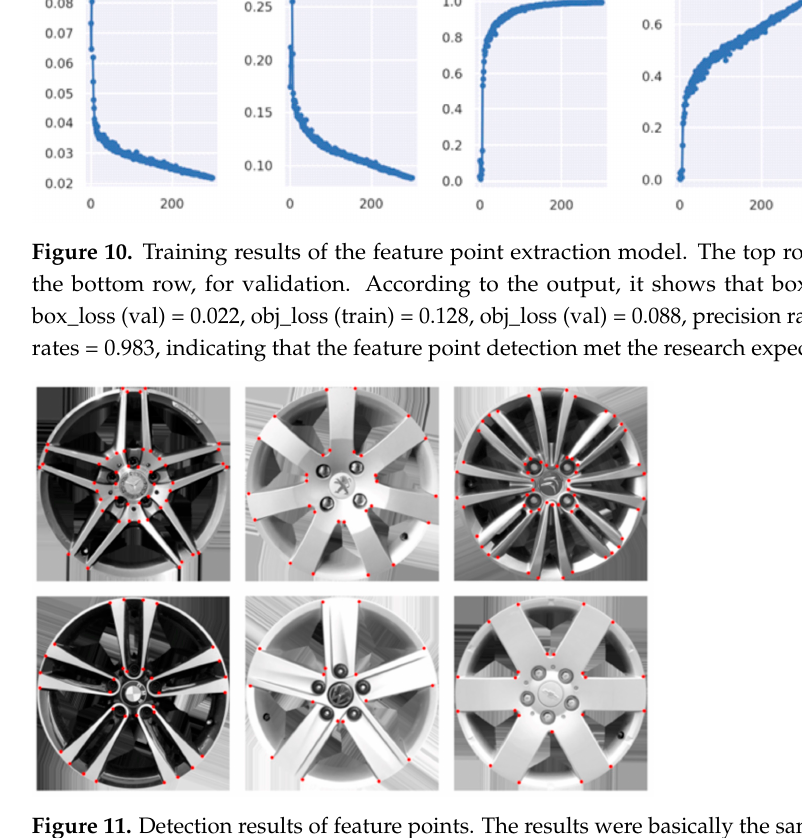
Figure 11. Detection results of feature points. The results were basically the same for different wheel shapes. The start point and midpoint of the wheel hub had good detection results. Partially missed endpoints can be filled in by subsequent processing.